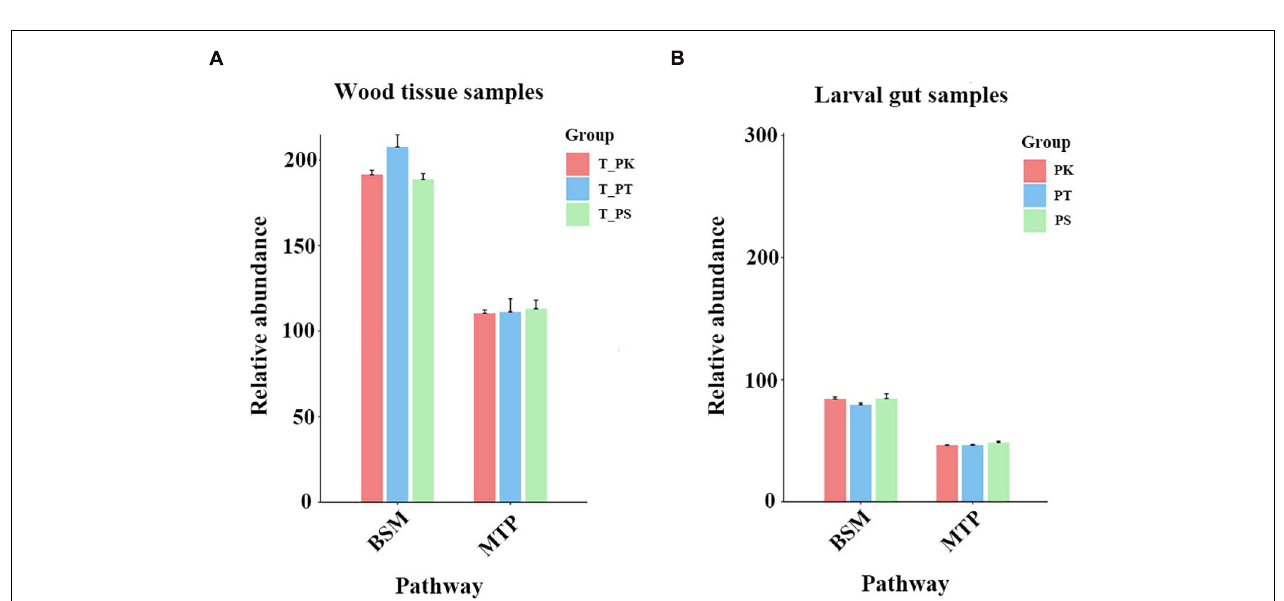
FIGURE 7 | Comparison of relative abundances of compounds annotated in three KEGG pathways. (A) Wood tissue samples. (B) Larval gut samples. BSM, biosynthesis of other secondary metabolites; MTP, metabolism of terpenoids and polyketides. Relative abundances were calculated by the sum normalization